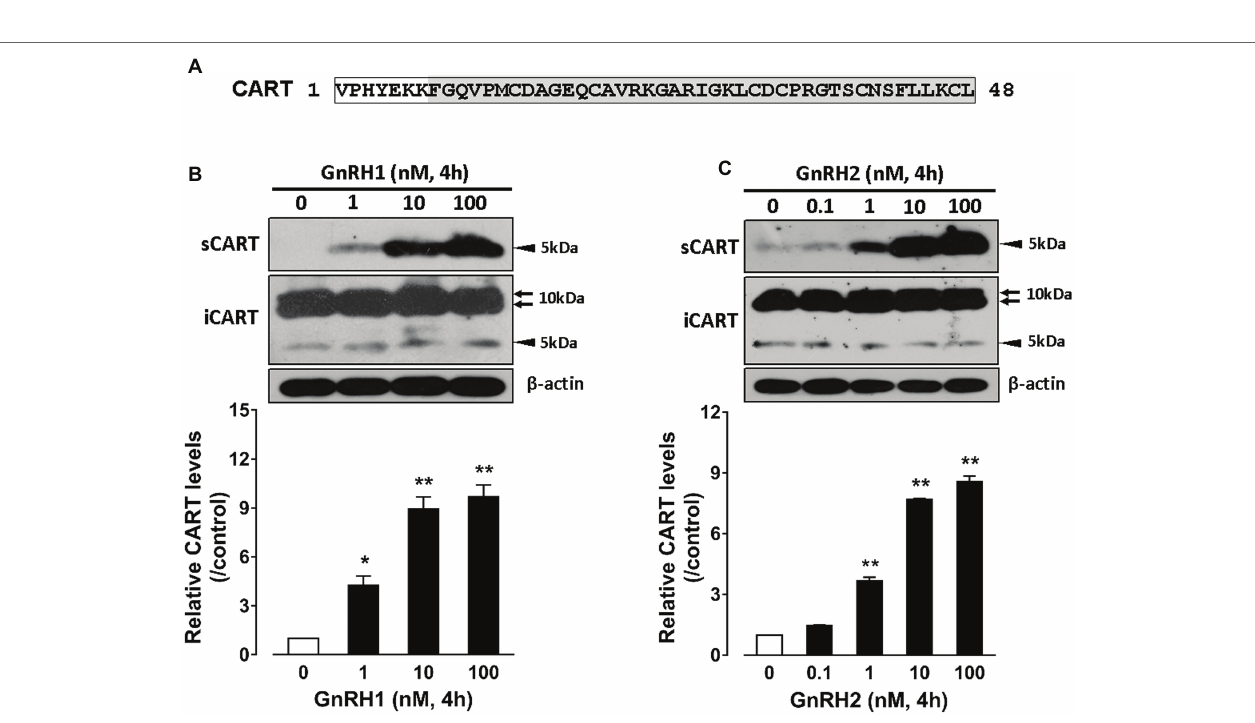
FIGURE 1 | (D) Enzyme-linked immunosorbent assay (ELISA) assay of plasma CART peptide levels in male chickens at the stages of 2-week-old (w2), 5-month-old (m5), and 15-month-old (m15). ** p < 0.01 vs. w2. Each data point in graphs represents mean ± SEM of four individuals ( N = 4). (E) Quantitative real-time PCR (qPCR) assay of CART , LH β , GnRHR2 , GH , and PRL mRNA levels in the Ce and Ca lobes of adult male chicken anterior pituitaries. Each data point represents mean ± SEM of 10 individuals ( N = 10). (F) RNA-Seq analyses of CART , GnRHR1 , and GnRHR2 mRNA levels in the hypothalamus (Hp) and anterior pituitary (Pi) of 1-week-old male